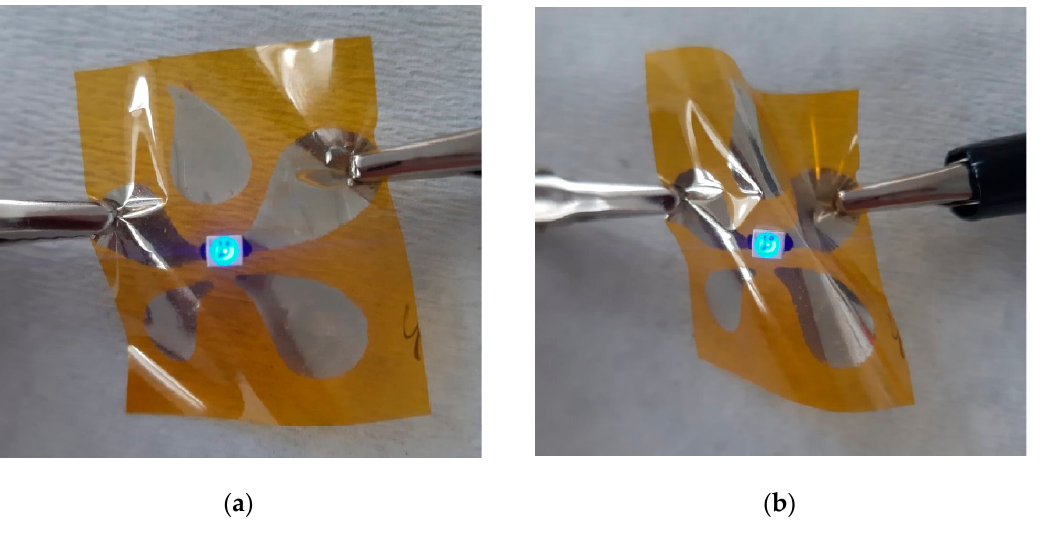
Figure 14. Institutional logo as an example of printed flexible electronics in ( a ) planar and ( b ) bended mode.